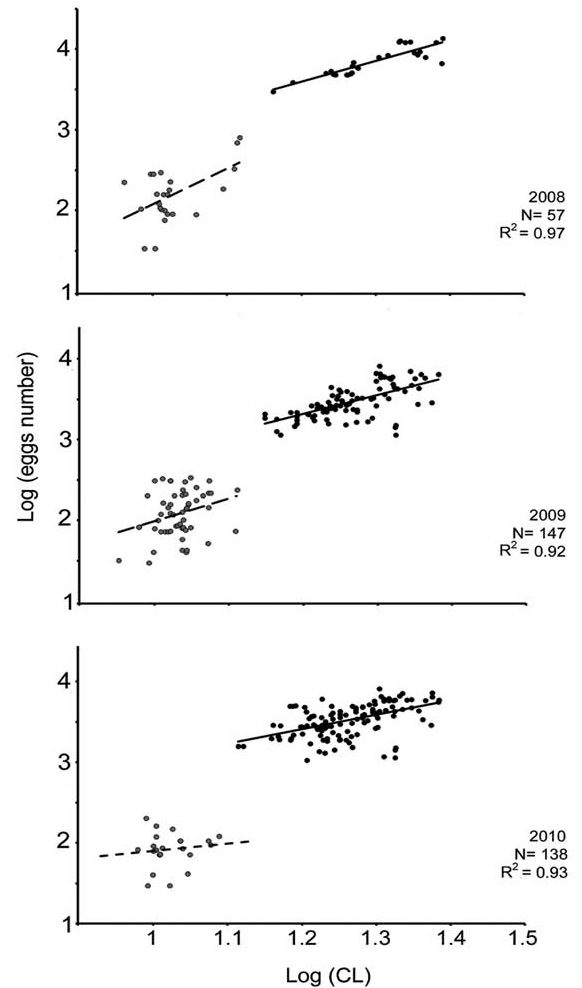
Fig. 10. – Fecundity and carapace length (CL) regressions of young of the year (grey) and older females (black) of Munida gregaria in the San Jorge Gulf. R 2 , determination coefficient of piecewise